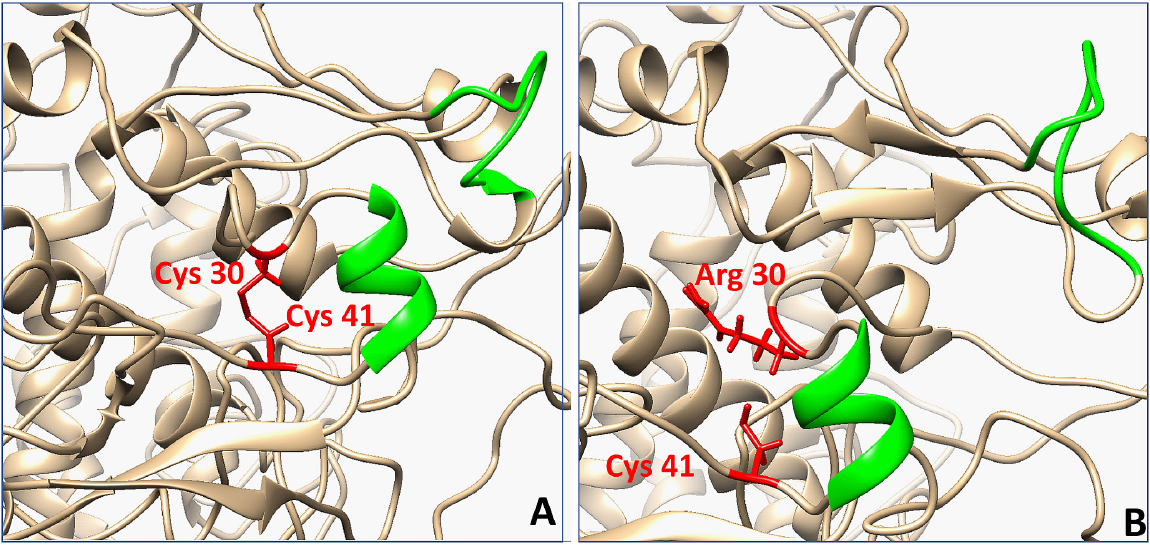
of residue-residue distance maps of the Tyrp1 ( A ) and the C30R ( B ) structures across five timestamps: Figure 3. A portion 0, 25, 50, 75, and 100 ns. Maps display the standard deviation of distances between residues. The C30-C41 region in Tyrp1 and R30-C-41 region in C30R were compared with a neighboring loop (E168-T176) to highlight the flexibility introduced by the C30R mutant within the Cys-rich subdomain. C30R shows a greater degree of fluctuation (maximum standard deviation of 4.87 Å) than Tyrp1 (maximum standard deviation of 1.19 Å).